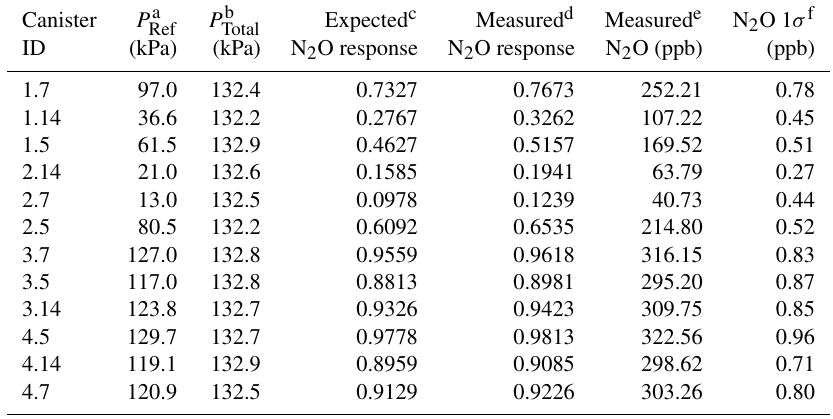
Table 1. Characteristics of 12 manometric N 2 O dilution samples prepared at Portland State University. P b Canister P a Expected c Measured d Measured e N 2 O 1 σ f Ref Total ID (kPa) (kPa) N 2 O response N 2 O response N 2 O (ppb)